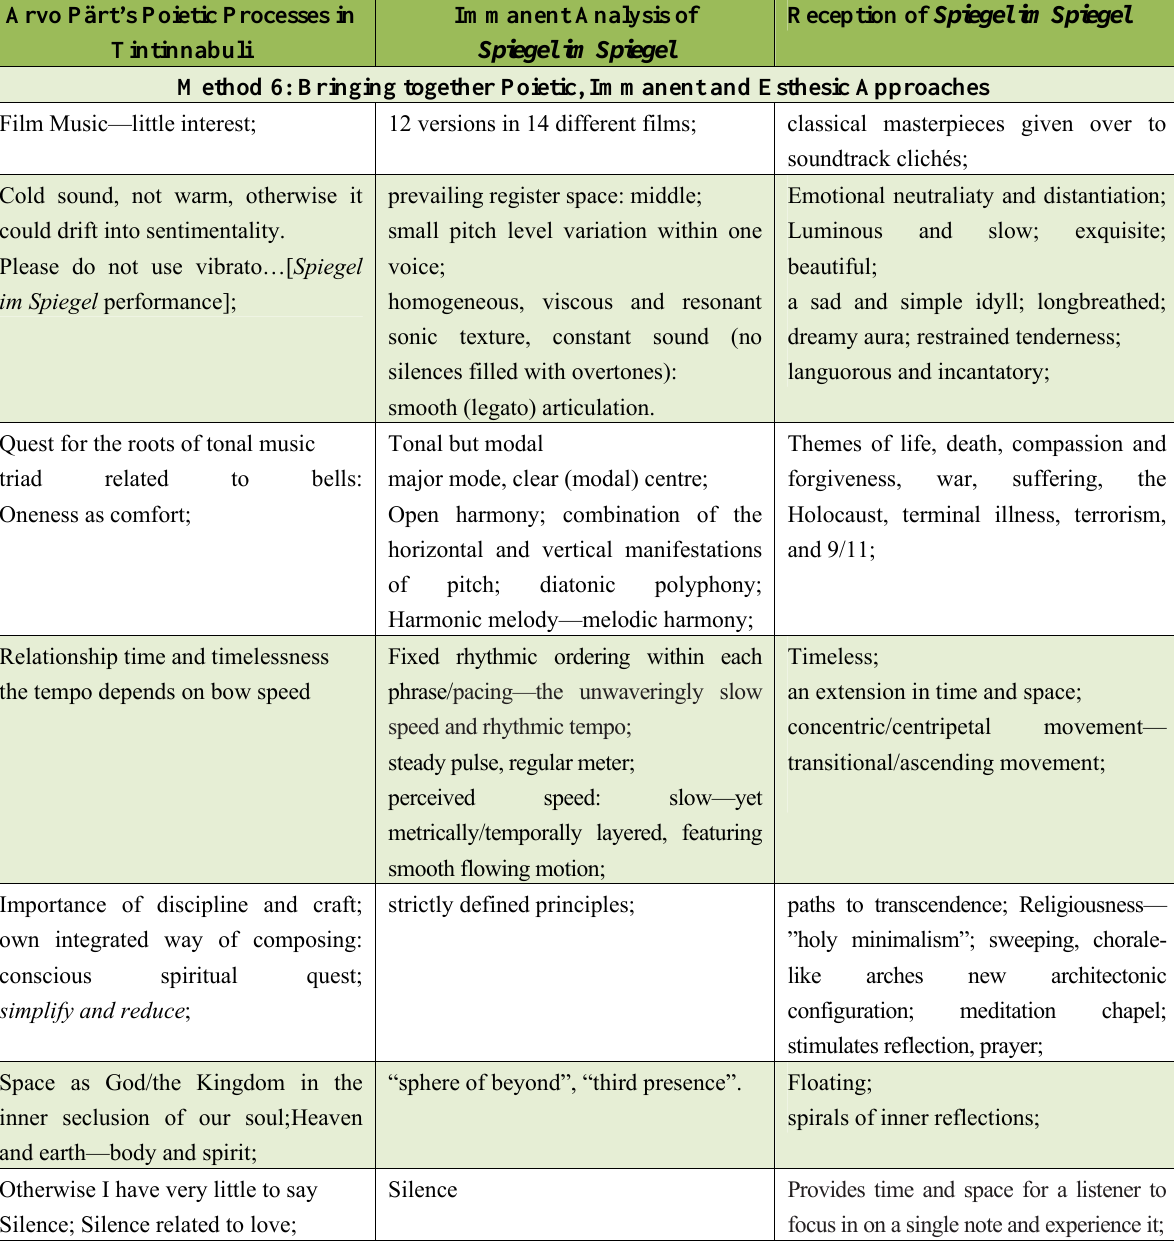
Table 2. Spiegel im Spiegel —Poietic, immanent and esthesic approaches [62]. Arvo Pärt’s Poietic Processes